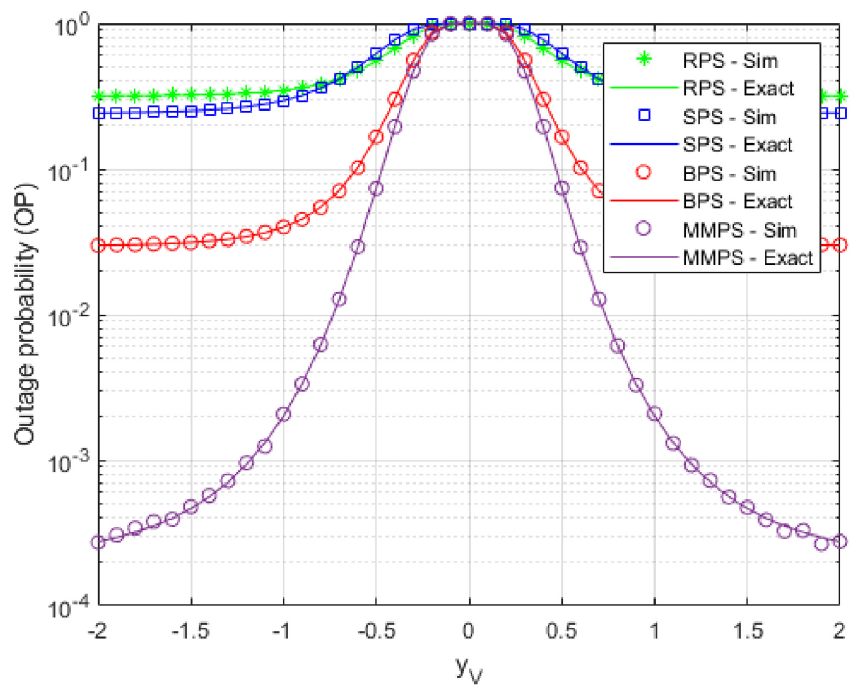
Fig 6. OP as a function of y